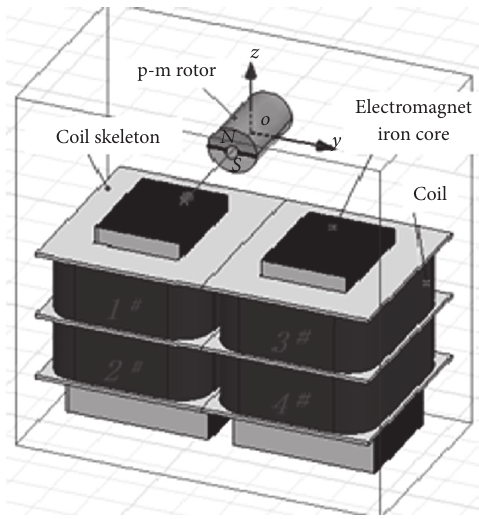
Figure 6: The three-dimensional simulation model of the magnetic drive